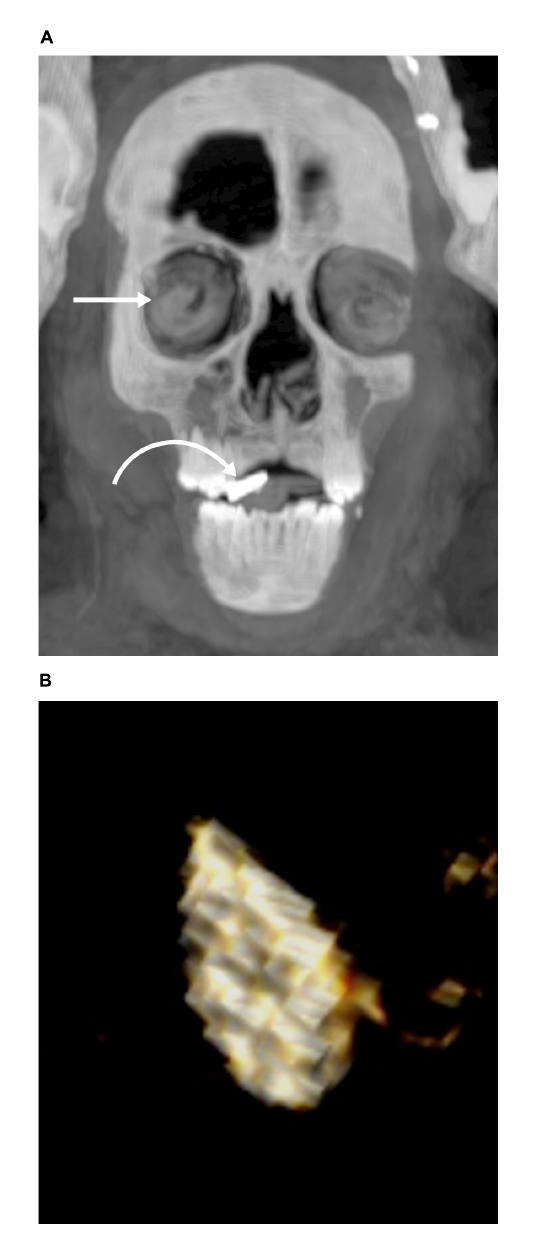
FIGURE10 Computed tomography (CT) images of the gold tongue amulet in the mouth of mummy TR 21/11/16 at the Cairo Egyptian Museum. (A) Thick slab coronal CT image of the mummy’s head shows a dense (gold) flat amulet inside the mouth (curved arrow). Note that the orbit is packed with linen (straight arrow). (B) Three-dimensional CT image of the amulet shows it has flat tongue like